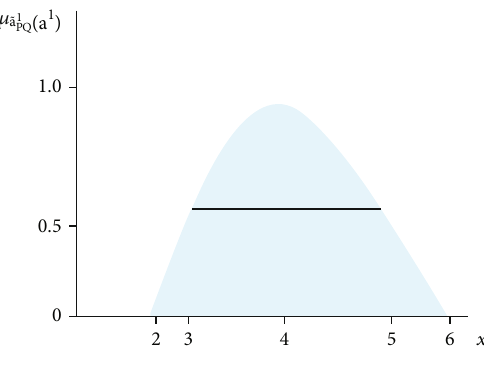
Figure 3: The function of membership μ